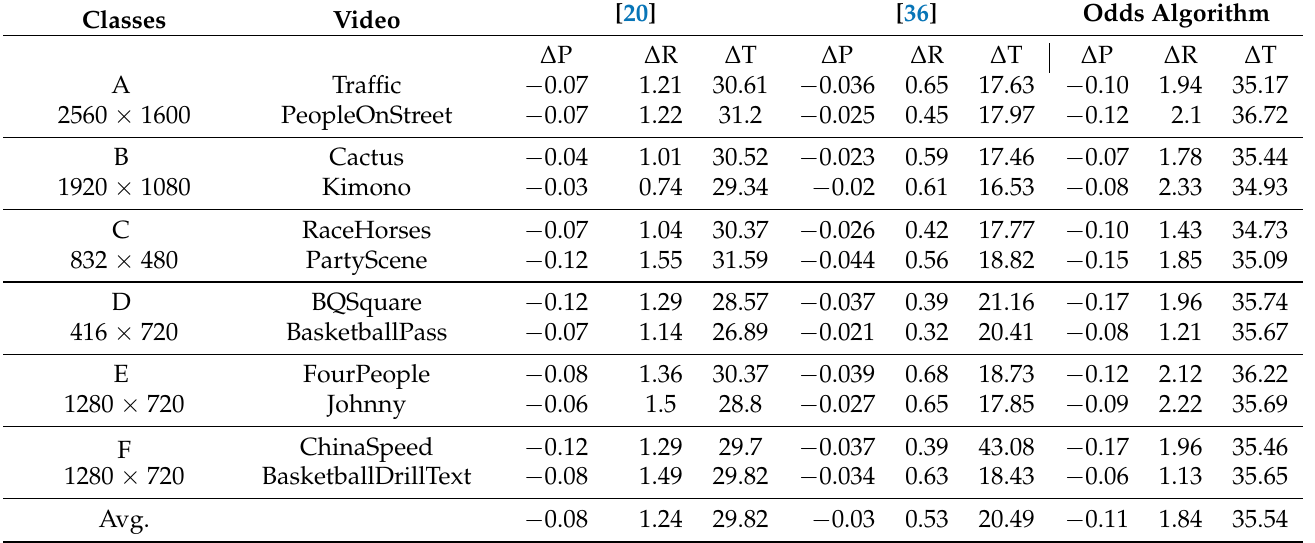
Table 2. Odds algorithm vs. existing algorithms.